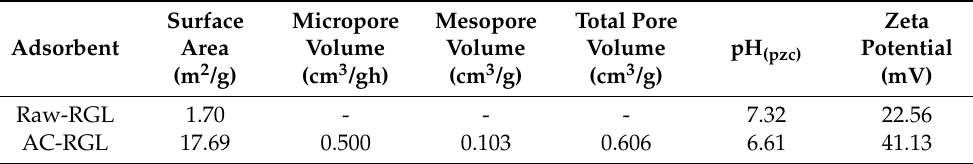
Table 3. Physicochemical characterization of Raw-RGL and AC-RGL